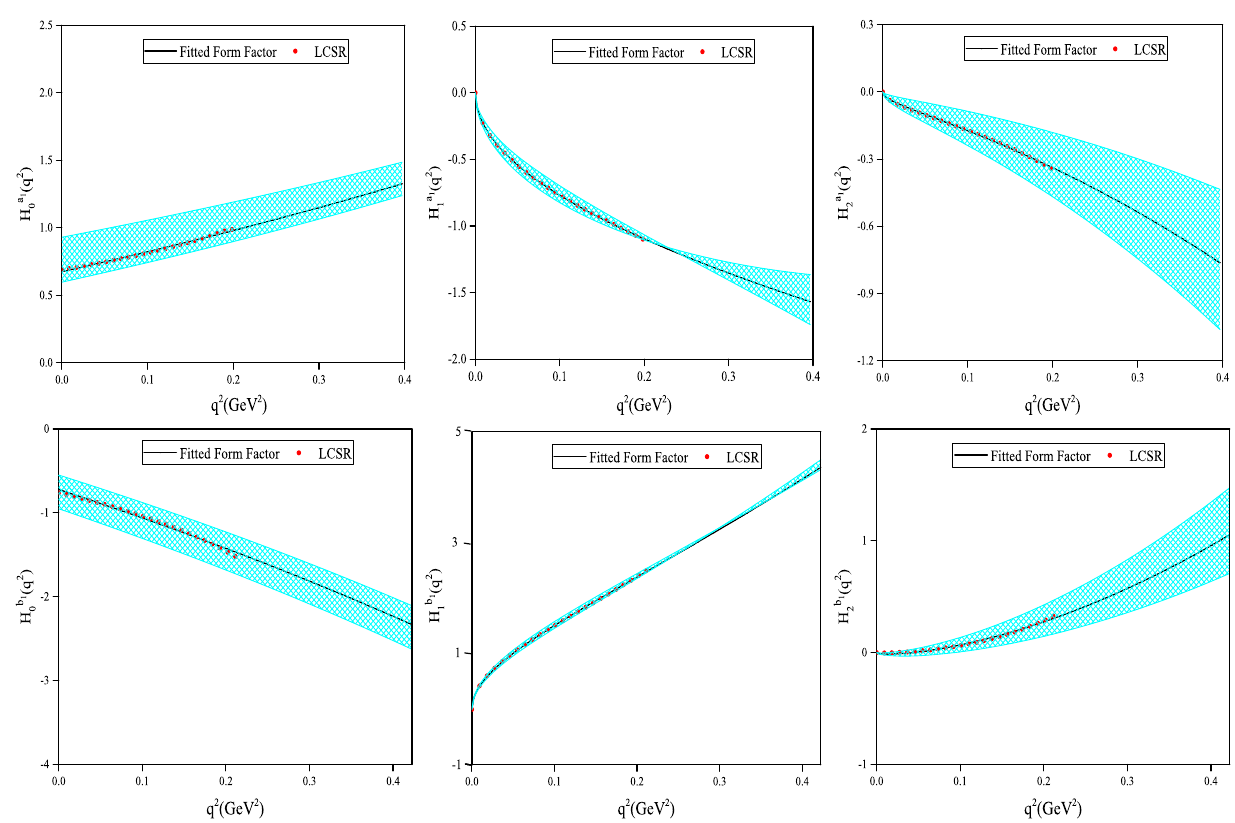
Fig. 4 D 0 → a − and D 0 → b − helicity form factors as a function of q 2 . Circles show the results of the LCSR while, black lines show the fitted 1 1 form factors in the whole physical regions. The shaded bands stand for the results correspond the upper and lower values of the input